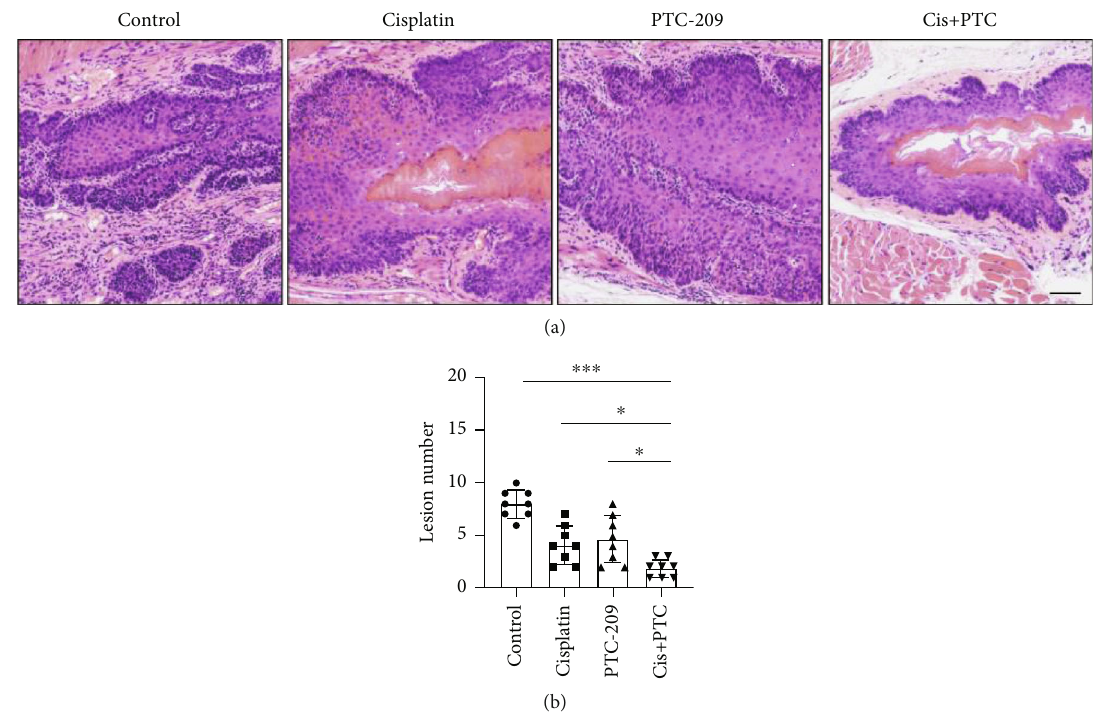
Figure 5: Treatment e ff ect of cisplatin combined with PTC-209 on ESCC. (a, b) From left to right, the histopathology (a) and histogram (b) of ESCC in the control group, cisplatin-treated group, PTC-209-treated group, and the cisplatin + PTC-209-treated group. The processing time of the four groups was four weeks. Cisplatin combined with PTC-209 has the lowest malignancy. ∗ p < 0 : 05 , ∗∗ p < 0 : 01 , and ∗∗∗ p < 0 : 001 . Scale bars are 100 μ